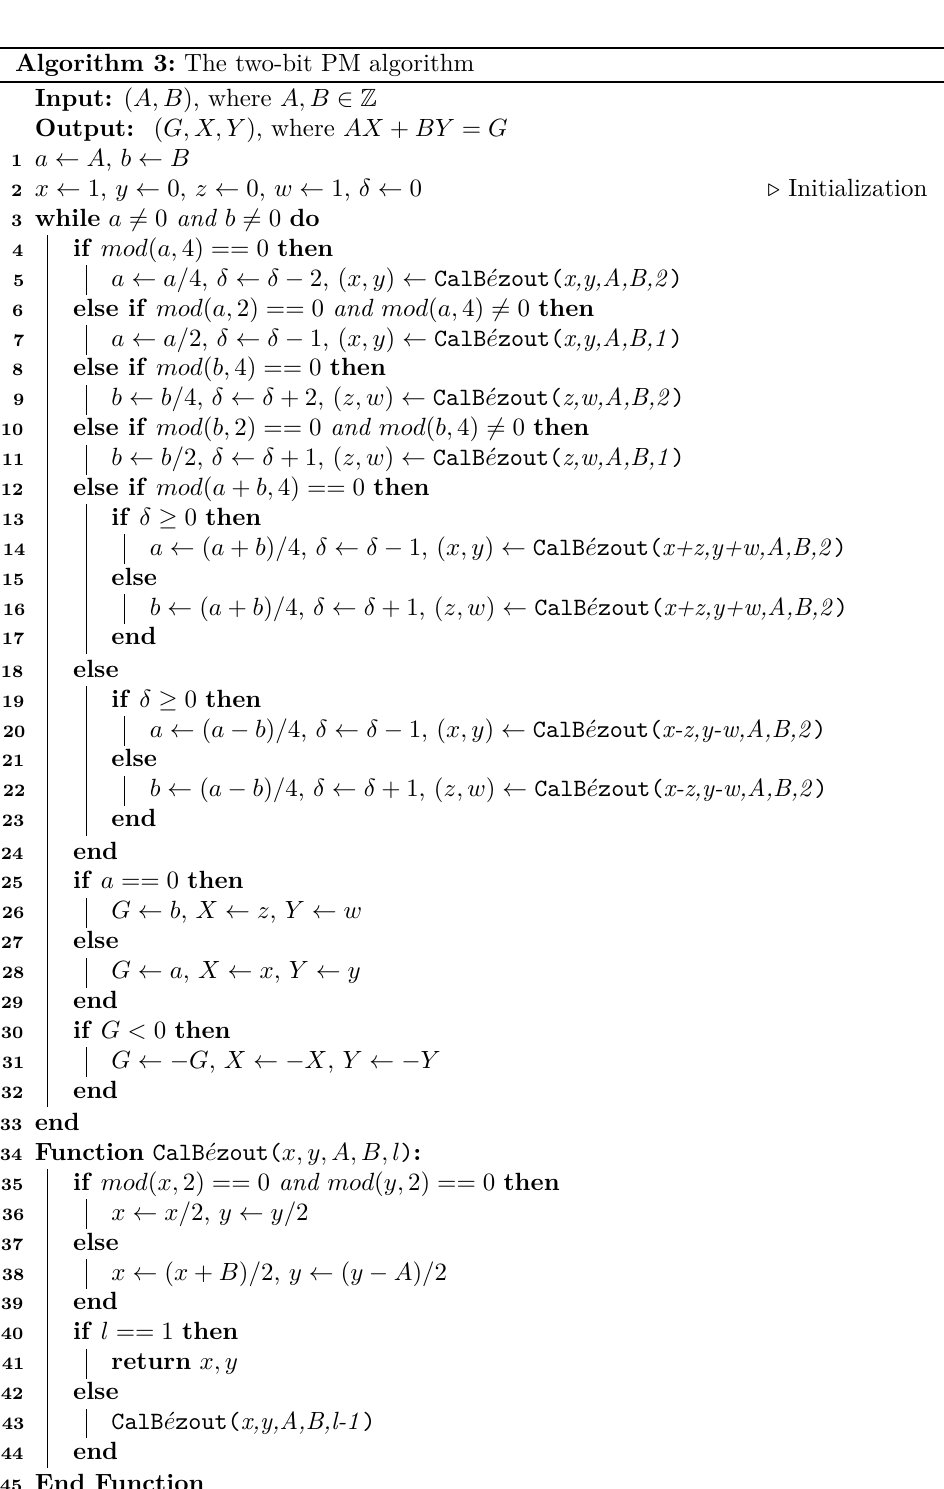
Algorithm 3: The two-bit PM